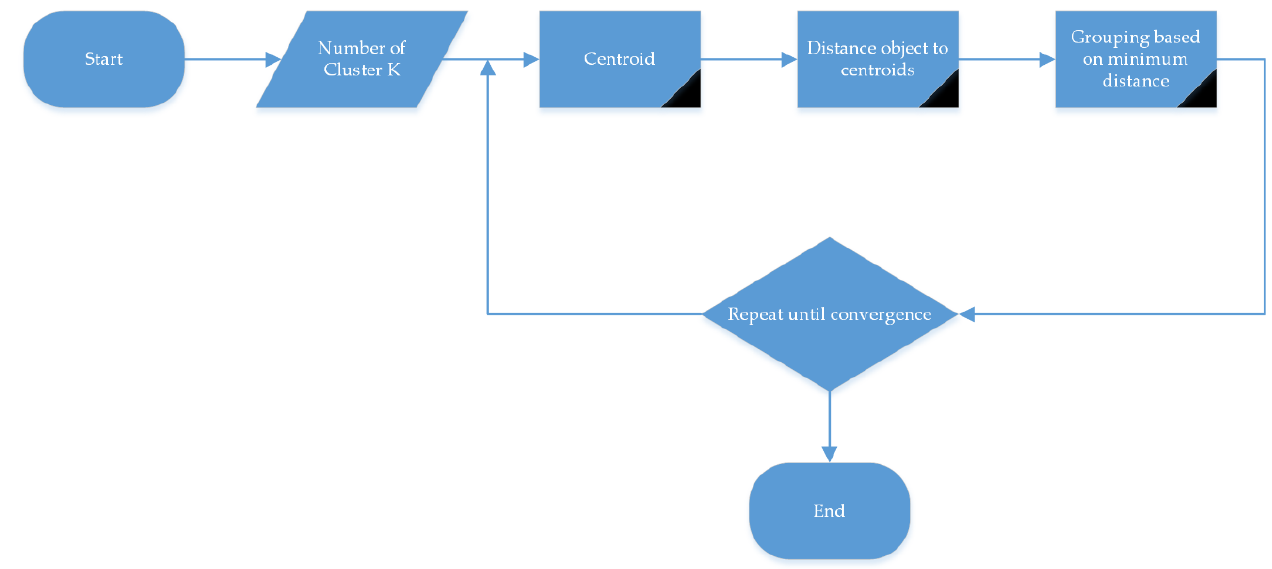
Figure 3. Flowchart of the proposed model.